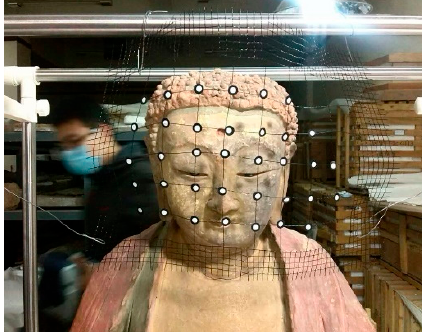
Figure 4. Design of the target net and fixed support.